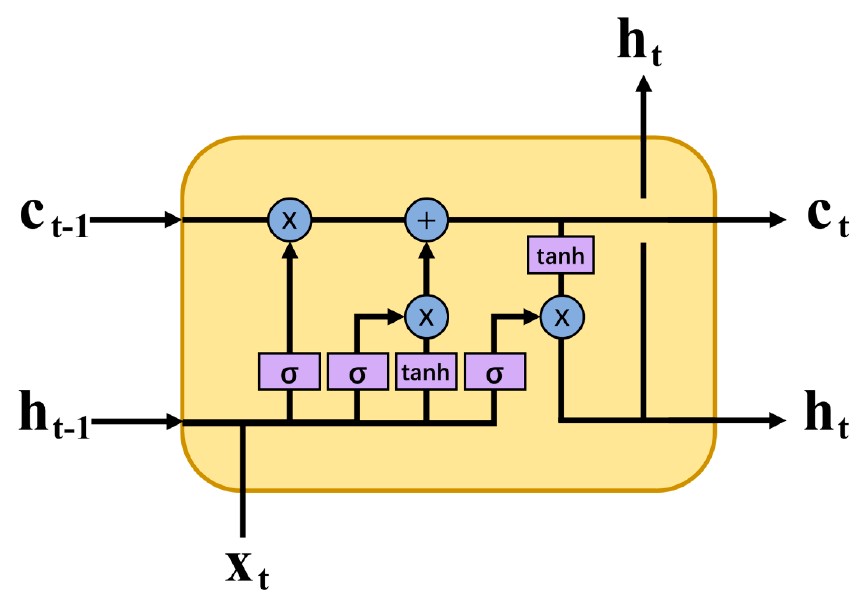
Figure 3. The long short-term memory network block architecture.